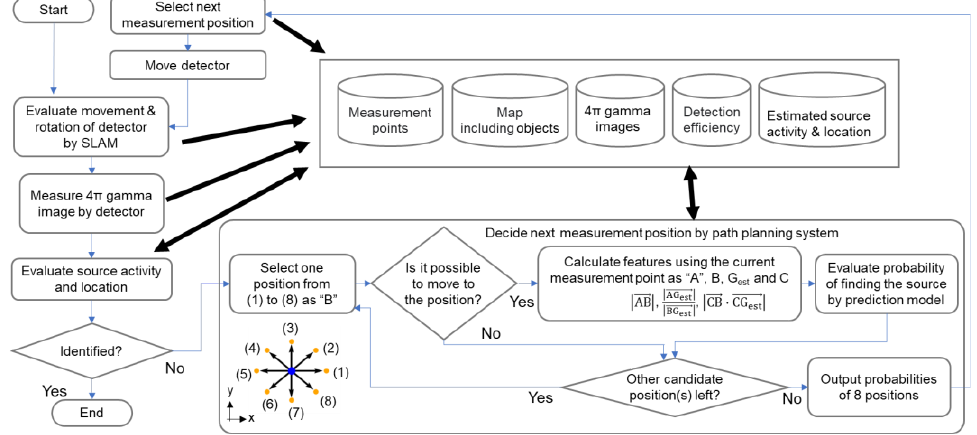
Figure 4. Flowchart of detector movement based on the proposed path-planning system.